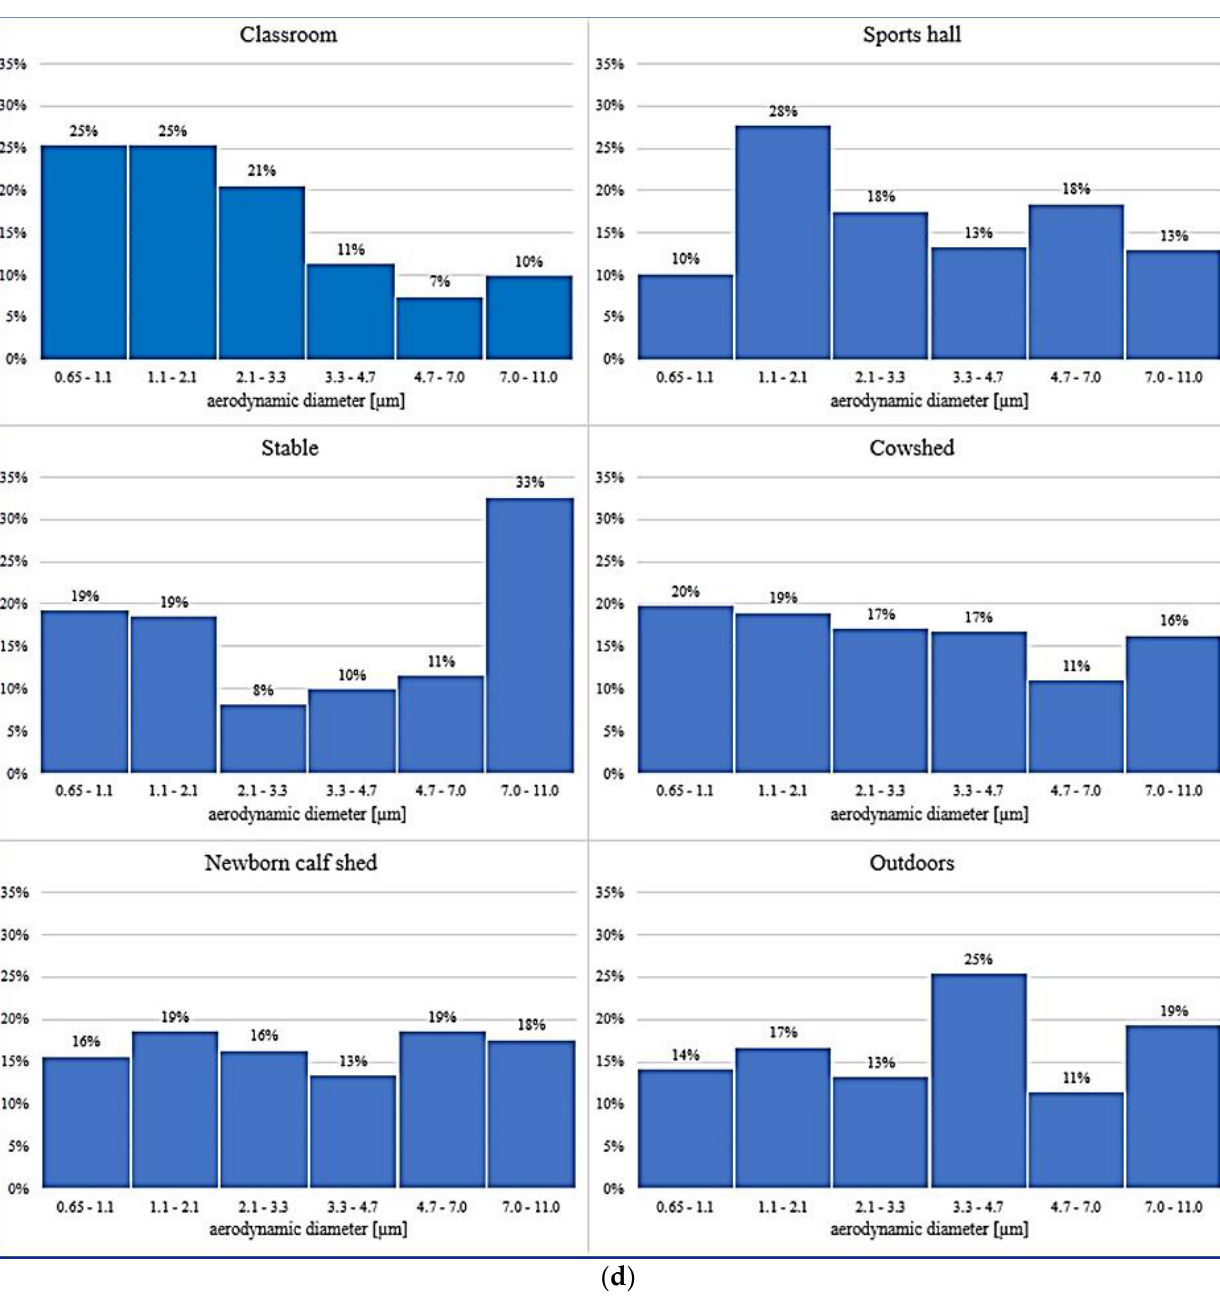
Figure 4. ( a ) Aerodynamic diameter distribution of bacteria in the examined points. ( b ) Aerodynamic diameter distribution of fungi in the examined points. ( c ) Aerodynamic diameter of staphylococci in the examined points. ( d ) Aerodynamic diameter of actinomycetes in the examined points.